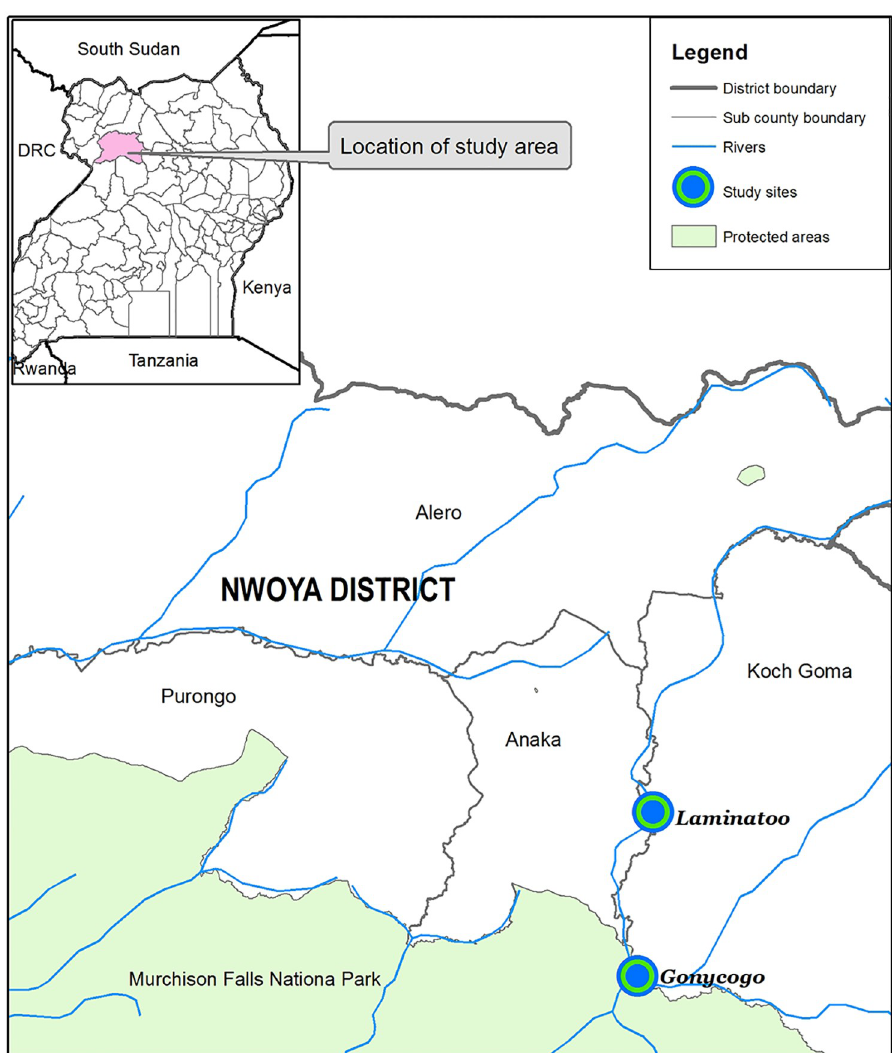
Fig 1. Location of Gonycogo and Laminatoo. This figure is reproduced from a previous publication describing the use of the EWT as a tool for entomological monitoring of O . volvulus transmission [12].